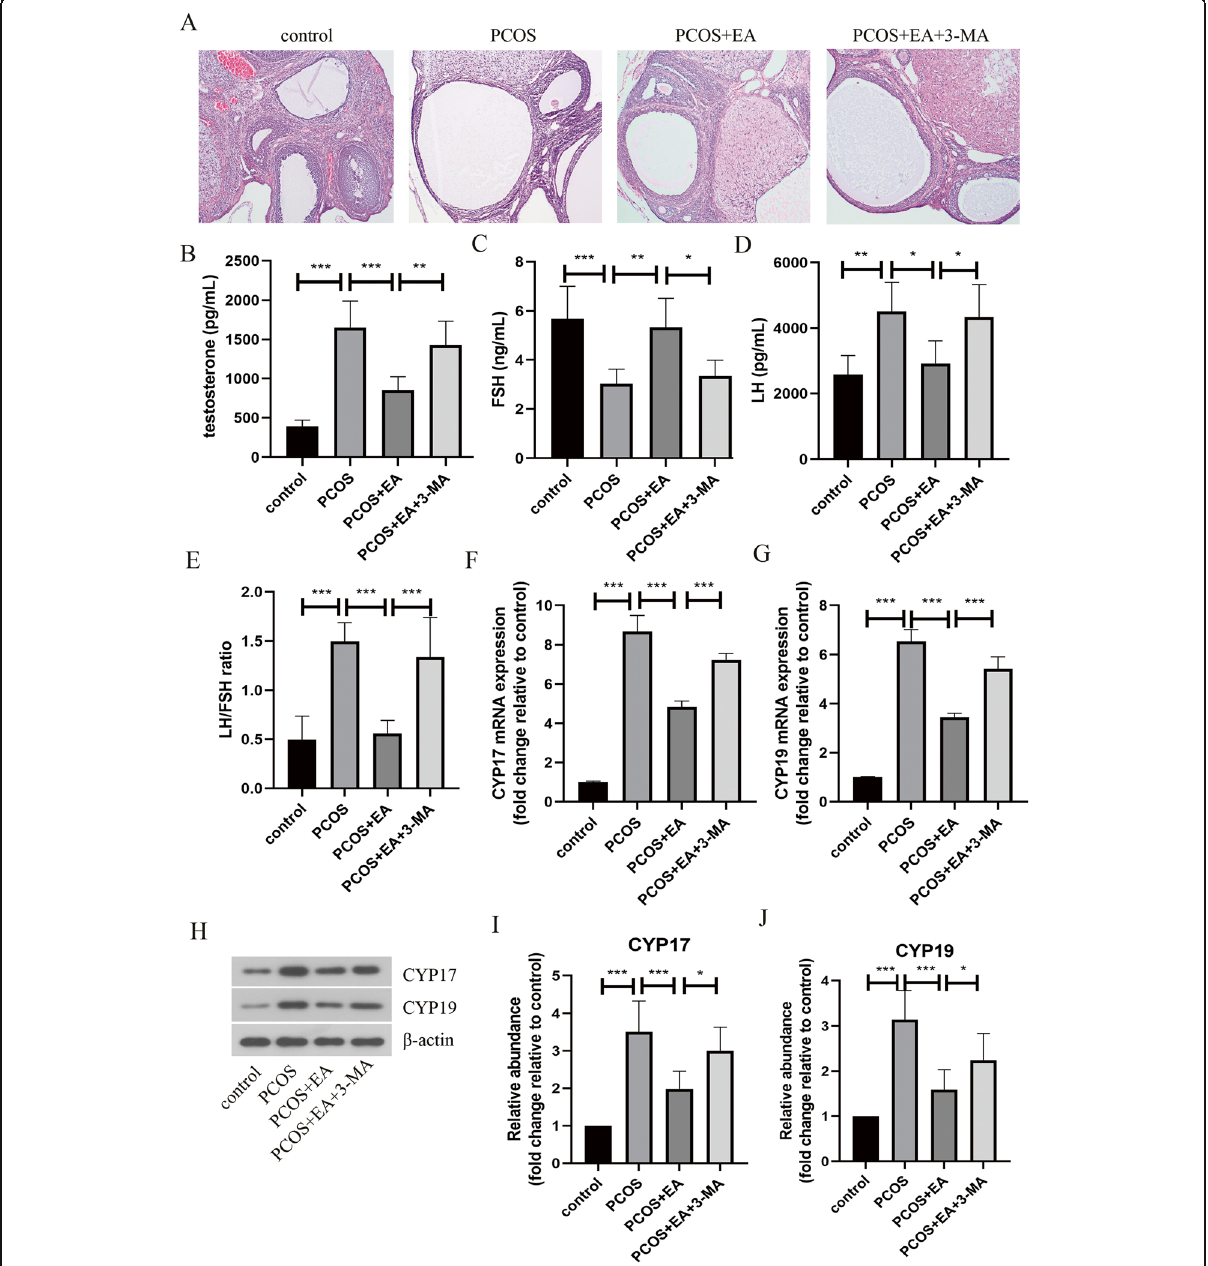
Fig. 1 Autophagy inhibition repressed the beneficial effect of EA on PCOS-like rats. a The pathological changes of ovarian tissues were determined by HE staining (100×). The serum levels of testosterone ( b ), FSH ( c ), and LH ( d ) were assessed by commercial ELISA kits. ( e ) The ratio of LH/FSH was calculated and shown. The mRNA expression of CYP17 ( f ) and CYP19 ( g ) was detected by real-time PCR. ( h - j ) The protein levels of CYP17 and CYP19 were evaluated by Western blotting. The experimental data are presented as mean±standard deviation ( n =6). * P <0.05, ** P <0.01, *** P <0.001, vs the indicated group. EA, electroacupuncture; PCOS, polycystic ovary syndrome; FSH, follicle stimulating hormone; LH, luteal